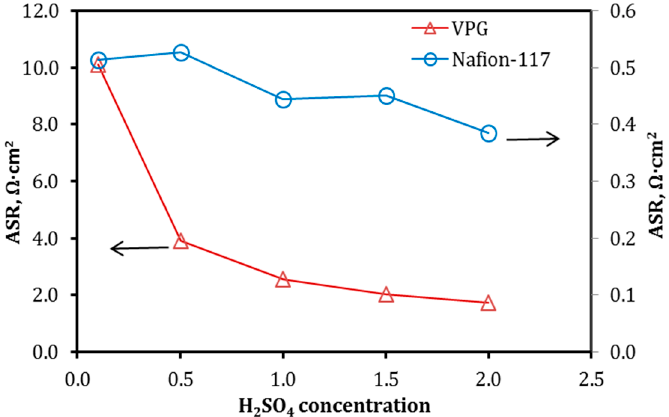
Figure 8. Area specific resistance (ASR) of the VPG and Nafion membranes as a function of H 2 SO 4 concentrations.